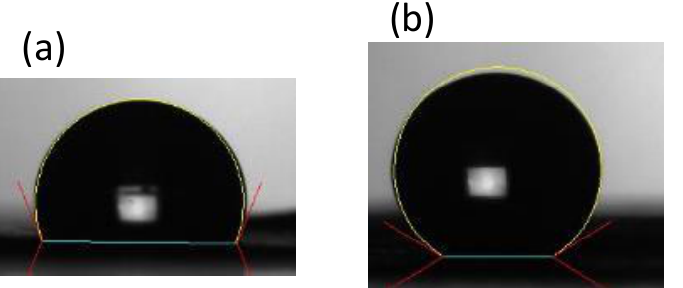
Figure 2. The toner coverage on the printed paper after printing ( a ) once, ( b ) twice, ( c ) three times, and ( d ) four times. Scale bar: 0.1 mm in (a) and 1 mm in (b). The scale bar in (b) also applies to (c) and (d).